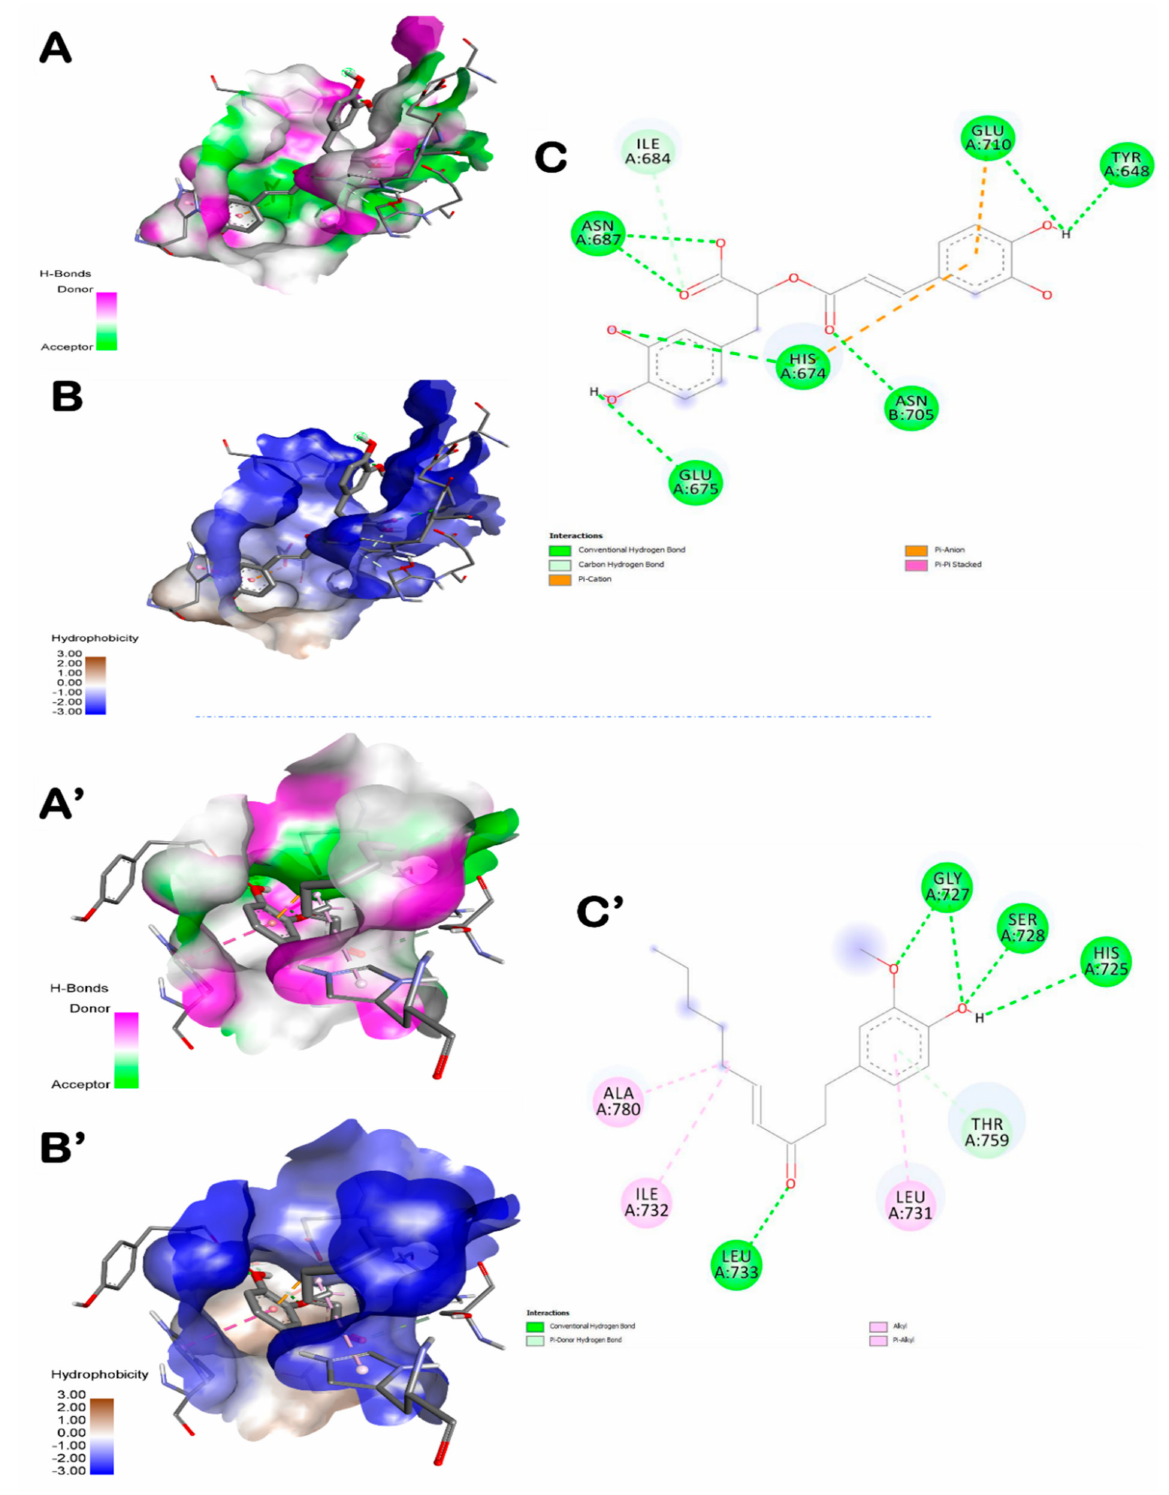
Figure 3. Representation of the 3D structure of ZO compounds (6-shogaol ( A – C ) and rosmarinic acid ( A’ – C’ )), with the highest docking scores, bounded to the pocket region of TLR6. Micrographs of the pocket region with hydrogen bond ( A , A’ ) and hydrophobicity illustrations ( B , B’ ) and the corresponding 2D diagram of interactions ( C , C’